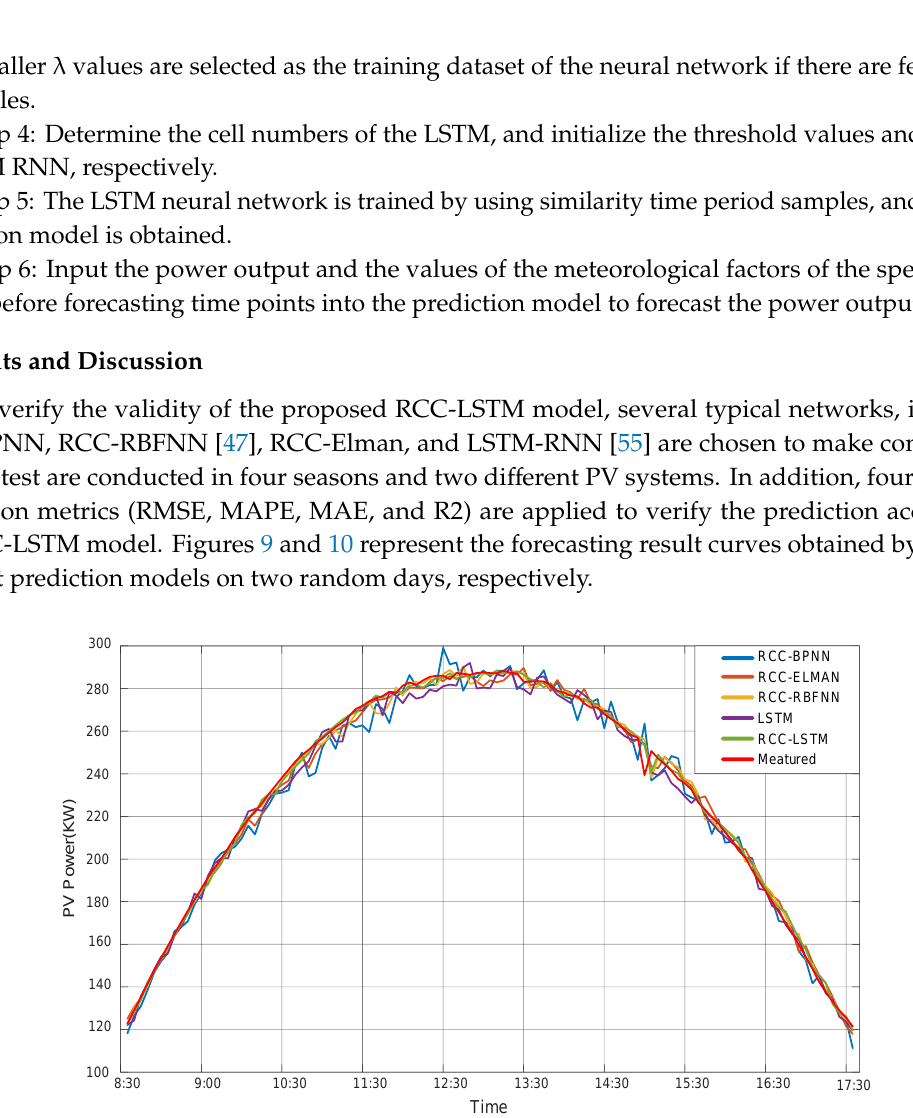
Electronics 2020 , 9 , x FOR PEER REVIEW Figure 9. Forecasting result curve by different models for random days in SITE 4. Figure 9. Forecasting result curve by di ff erent models for random days in SITE 4.